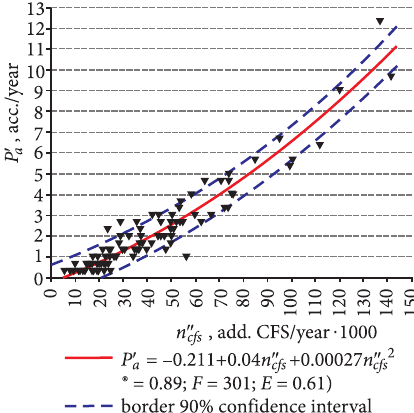
Fig. 4. The reduced accident rate dependence on the reduced conflict situations (conflict No. 3, the advanced